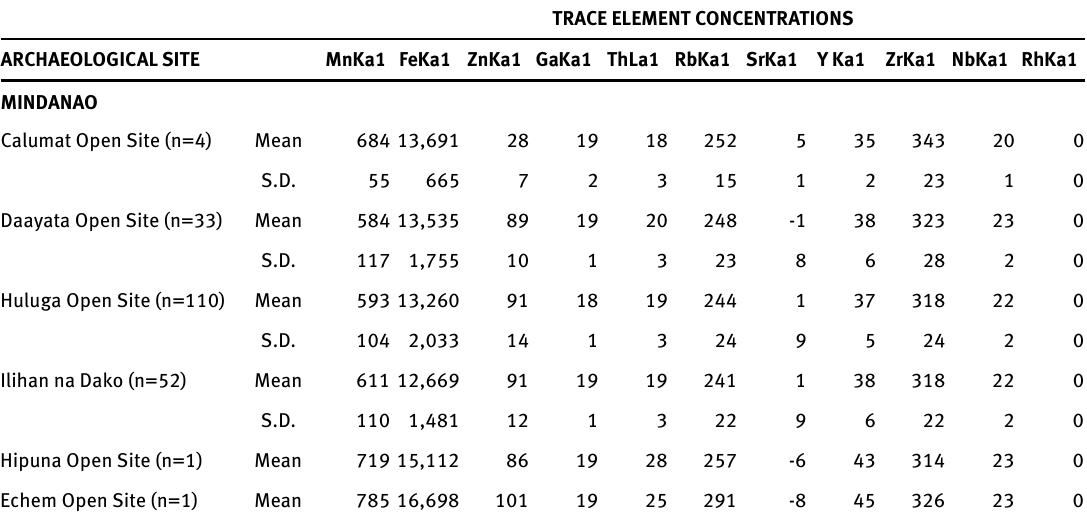
Table 2. Descriptive statistics of the Northern Mindanao archaeological sites using pXRF.